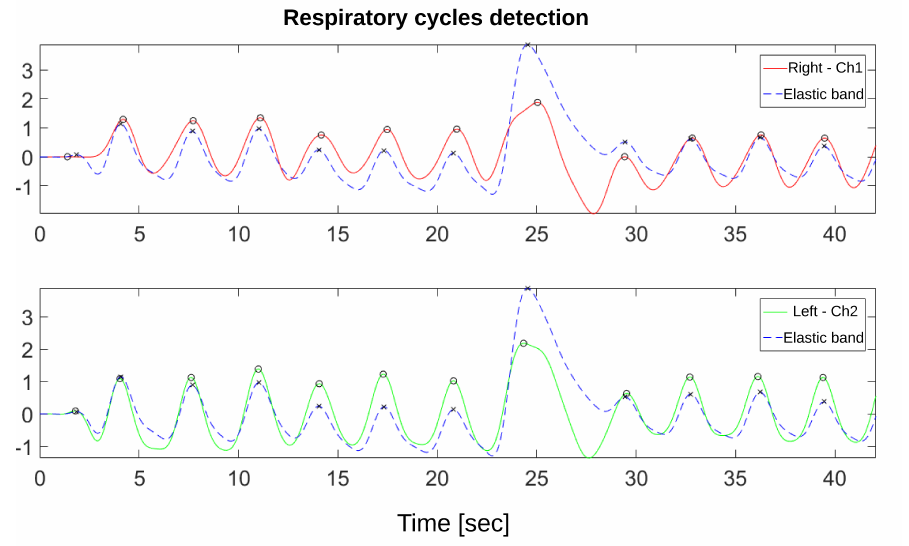
Figure 13. Identification of respiratory cycles using peak detection. Top image: channel 1 TEB variation signal (red) with detected peaks marked with “O”, and resistive band signal (blue) with peaks marked with “X”. Bottom image: channel 2 TEB variation signal (green) with detected peaks marked with “O”, and resistive band signal (blue) with peaks marked with